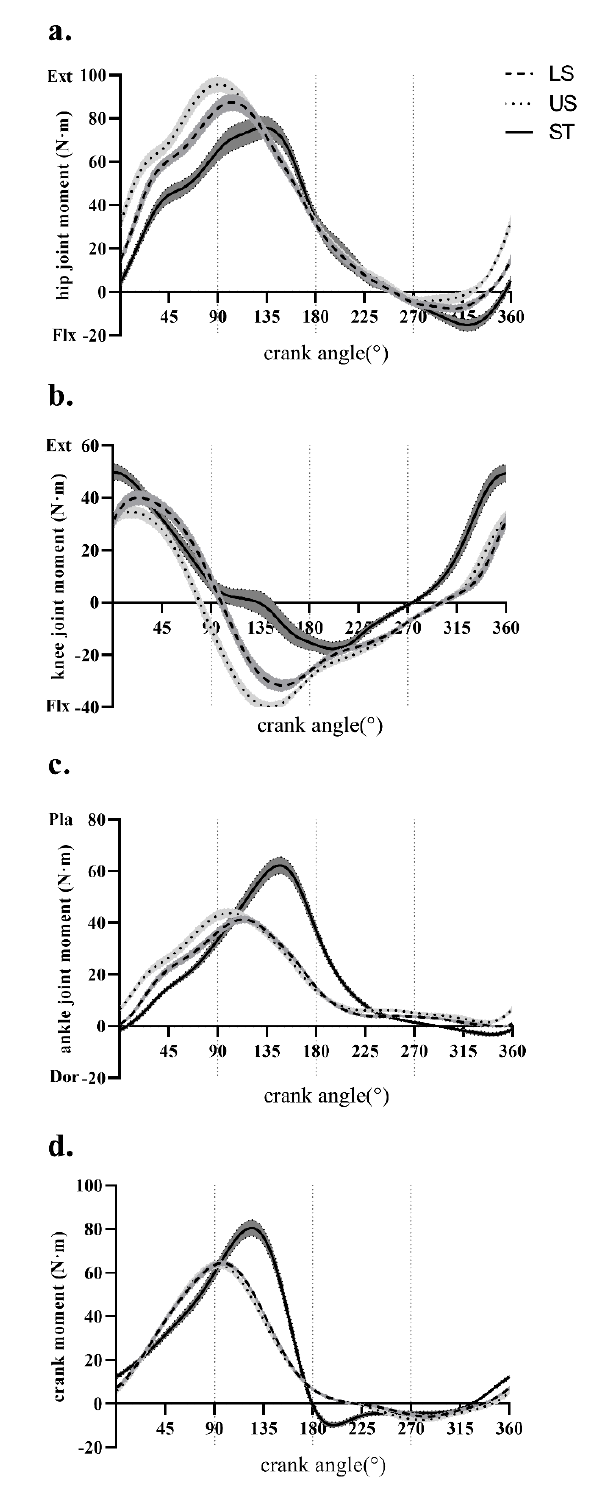
Figure 2. Average curves of the ( a ) hip joint, ( b ) knee joint, ( c ) ankle joint moments and the ( d ) crank moment (±SEM) in level seated (LS), uphill seated (US) and uphill standing (ST) conditions at a constant power output; ( a ) hip joint moment; ( b ) Knee joint moment; ( c ) ankle joint moment; ( d ) crank moment; Dor, Dorsiflexion; Ext, extension; Flx, flexion; Pla, plantarflexion; The vertical dash line in 90 ° , 180 ° and 270 ° refers to the border between each adjacent phase from P1 to P4.